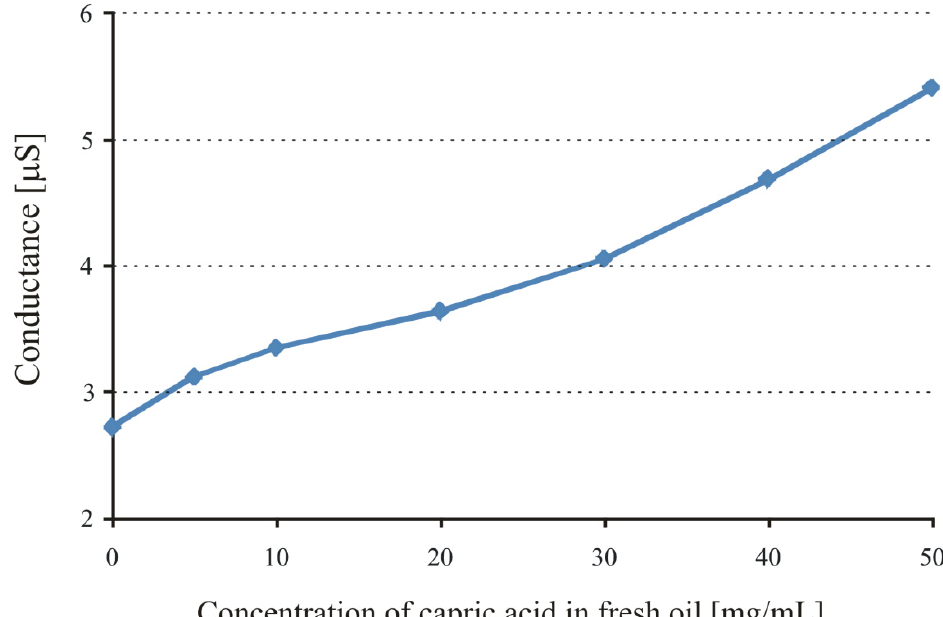
Figure 5. Sensor responses of imprinted polymer layer (APTES) while exposing to fresh oil with different concentrations of capric